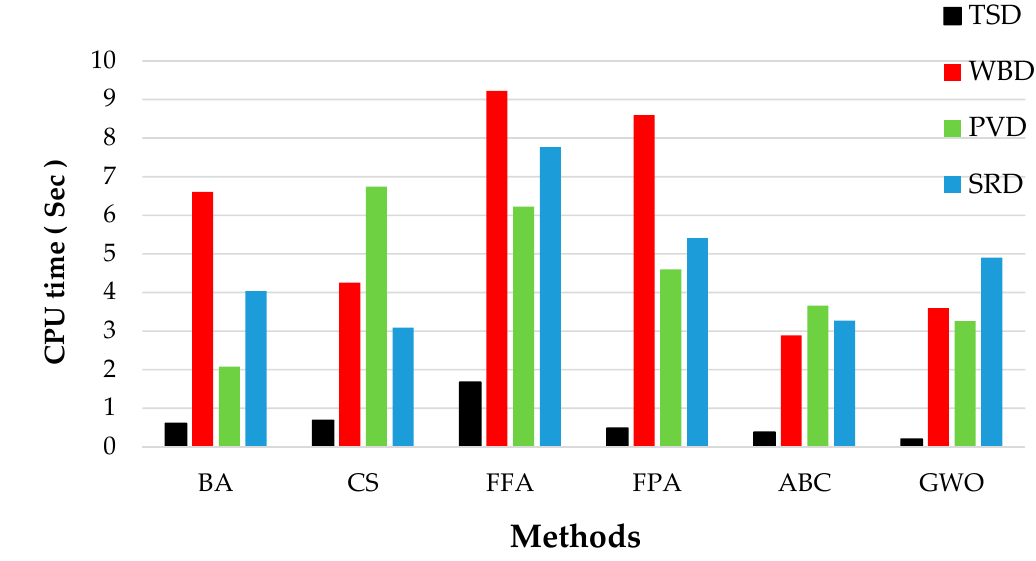
Figure 13. Required CPU time by each algorithm for all constrained problems.